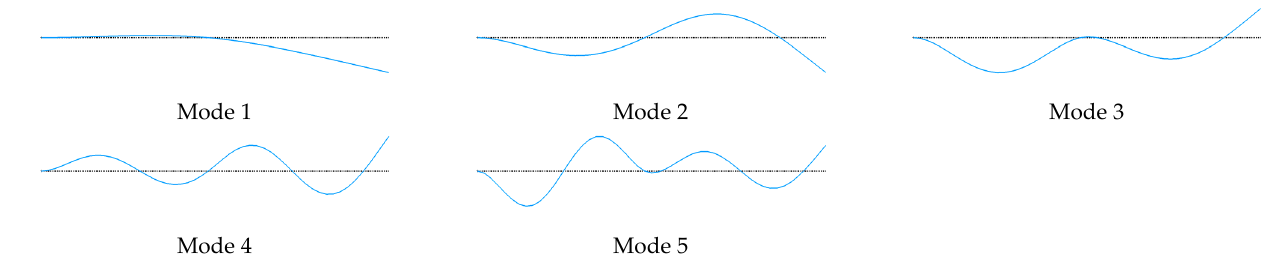
Figure A1. First five elastic modes with BC1: y ( 0 ) = y (cid:48) ( 0 ) = y ( L /2 ) = 0.